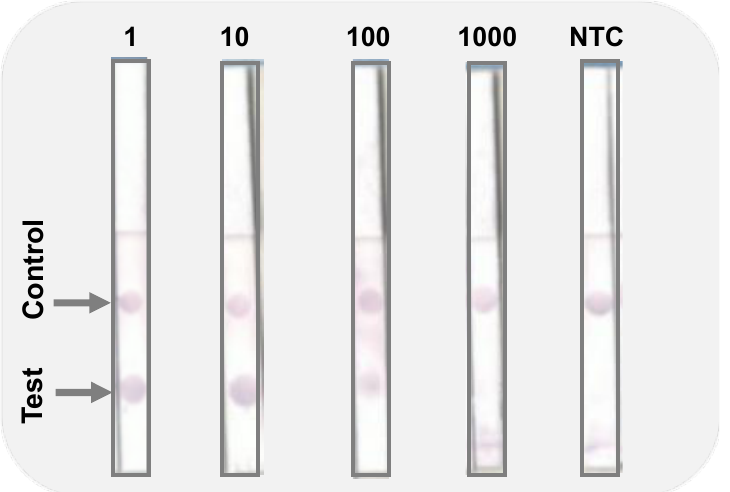
Figure 3. Images of the immuno-dipstick for detection of C. gloeosporioides DNA without dilution (1); diluted 10-fold (10); diluted 100-fold (100); 1000-fold (1000); no template control (NTC). Test and control dots are indicated by arrows.